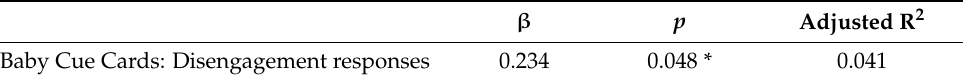
Table 5. Results of regression analysis conducted to examine the associations of the MIBQ total score with the demographic variables and scores on the social cognitive